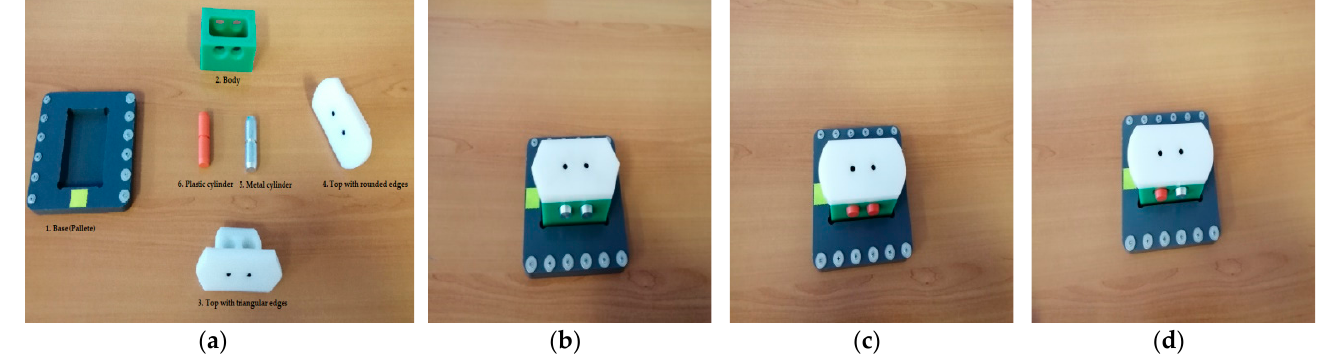
Figure 3. ( a ) workpiece parts, assembled workpieces: ( b ) workpiece with metal cylinders; ( c ) workpiece with plastic cylinders; ( d ) workpiece with different material cylinders.